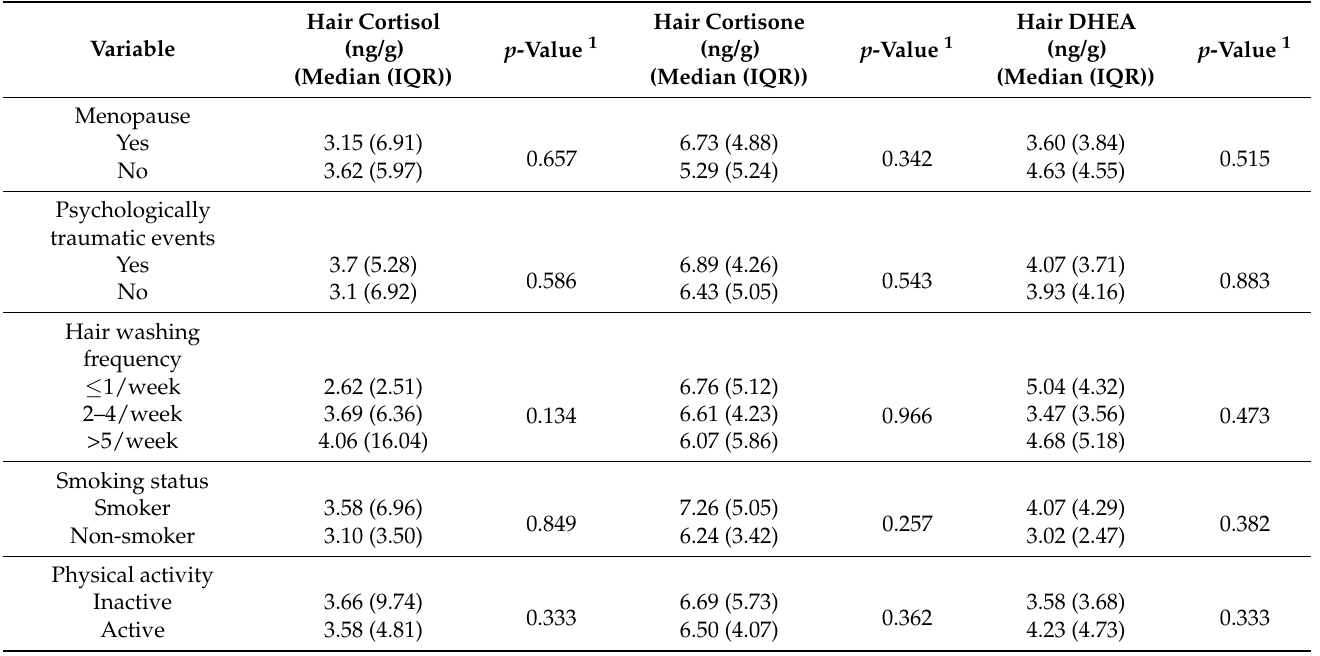
Table 4. Comparison of steroid hormone levels in the subject groups based on the health-related factors, hair washing frequency or lifestyle